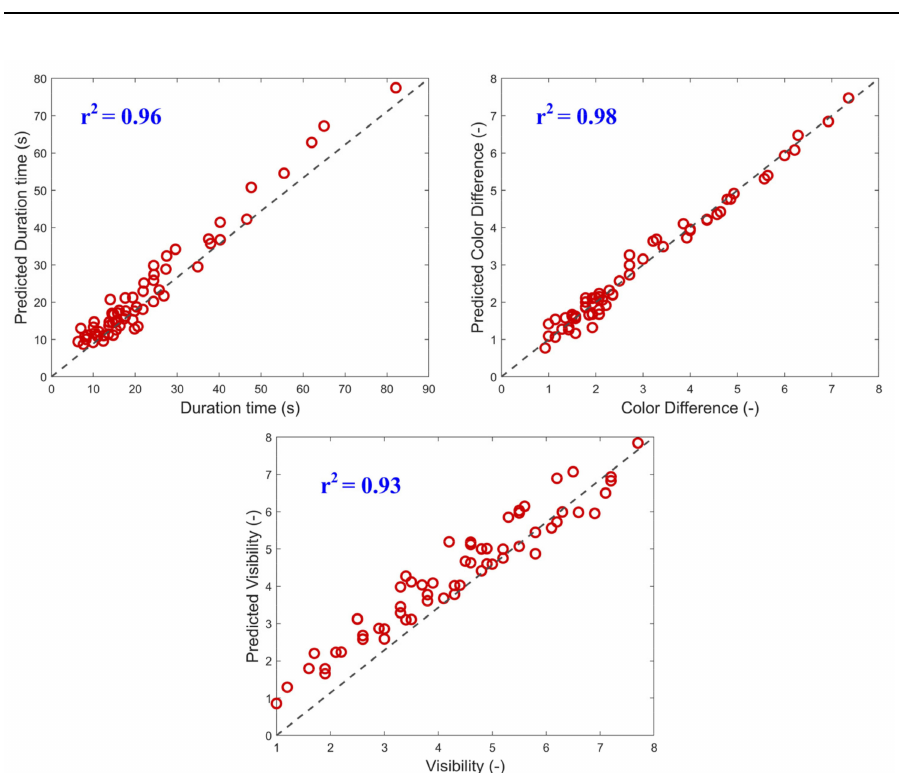
Figure 12. Scatter plots of the